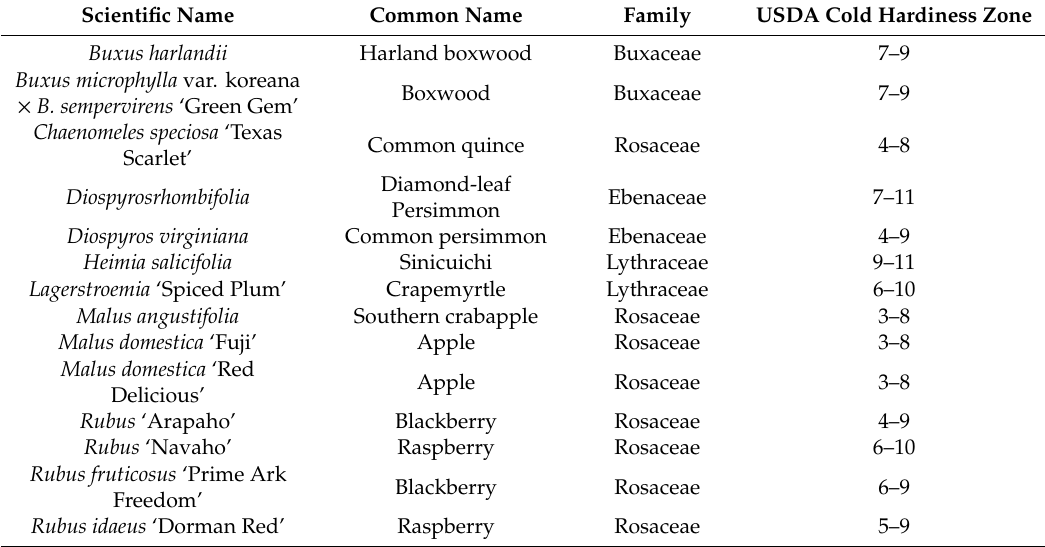
Table 2. Plant species as host candidates of Acanthococcus lagerstroemiae used in feeding preference study in